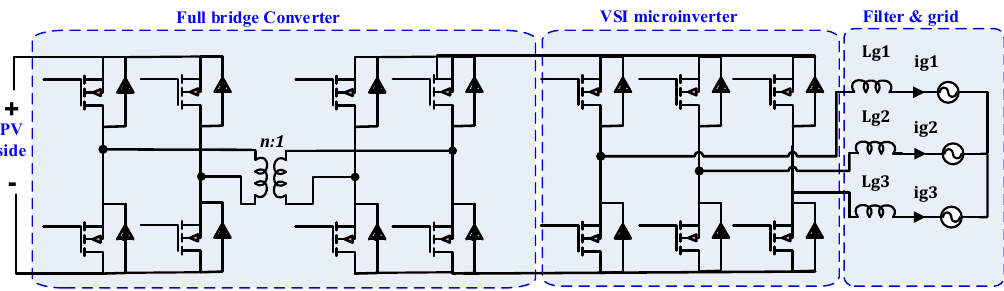
Figure 19. Two-stage three-phase microinverter proposed by Huang and Mazumder [107].